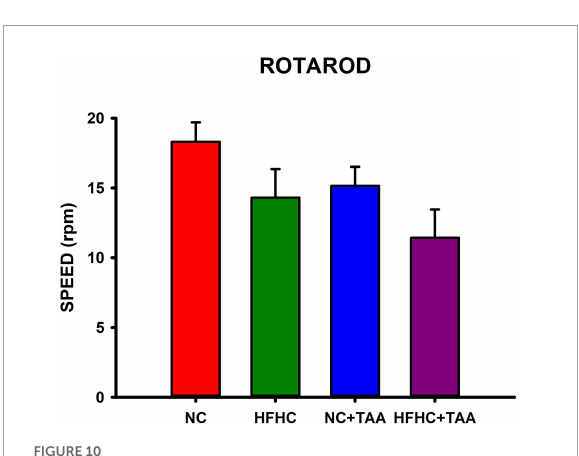
FIGURE10 Locomotor function evaluation measured in Rotarod-accelerod test. Bars charts (mean ± SEM) represent the maximum speed (rpm) that the animals spent on the rod, which was compared through the Kruskal–Wallis test. There were no statistically significant differences between